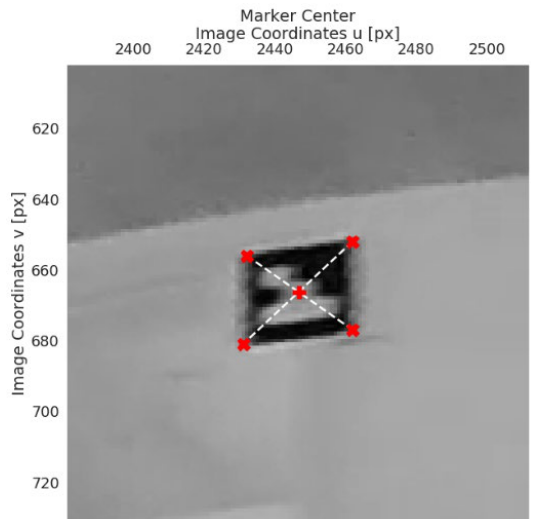
Figure 4. Detected marker in cropped camera frame 4.3.4 Marker Centre Calculation: Since the detected marker can be distorted, the marker centre is calculated by the intersection of the two diagonals of the marker corners (Figure 4). 4.3.5 Direction Calculation: From the coordinates of the marker centre and the image size, the horizontal and vertical direction of the marker in respect to the camera can be calculated. If the camera model is equirectangular, this calculation becomes simple, with other camera models or when using an multi head system, the intrinsic and relative camera calibration are needed (Figure 5).